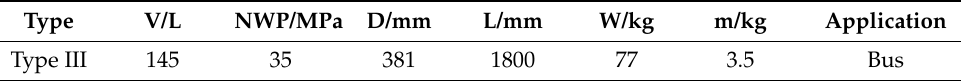
Table 1. Parameters of the Hydrogen tanks.